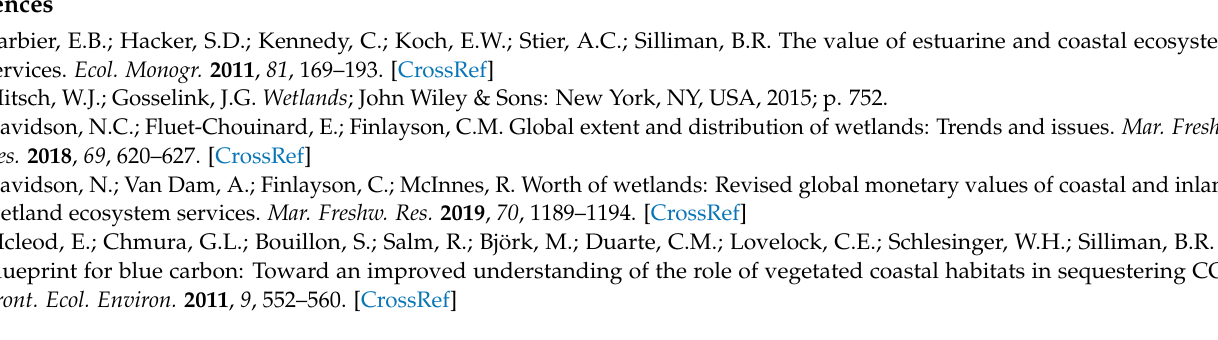
sessment; Table S2: Change maps accuracy assessment; Figure S1: Frequency distribution of open water pond sizes for each 1940 and 2012 classification across minimum mapping